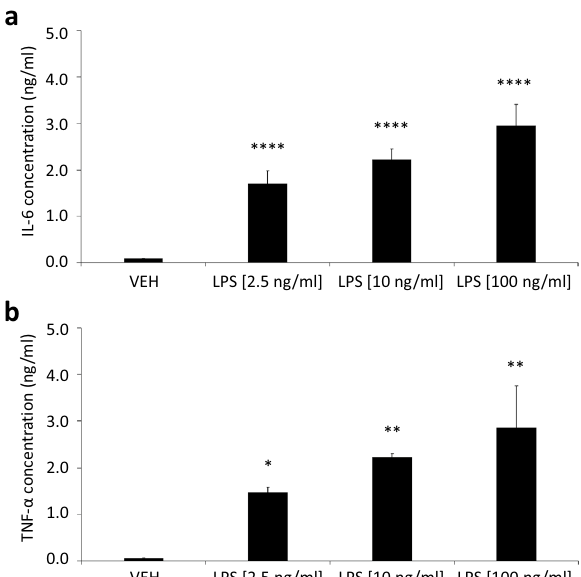
Figure 2. Significant SIM-A9 microglial cells cytokine secretion after LPS stimulation. Culture medium from SIM-A9 microglial cells stimulated with varying concentrations of LPS (2.5 ng/ml; 10 ng/ml; 100 ng/ml) were collected after 18 h-treatment ( N = 2–4 per condition), and IL-6 ( a ) and TNF-α ( b ) concentrations were determined by ELISA. Data represent the mean ± s.d. One-way ANOVA **** P < 0.0001, ** P < 0.01, * P < 0.05 to Vehicle (VEH; 0